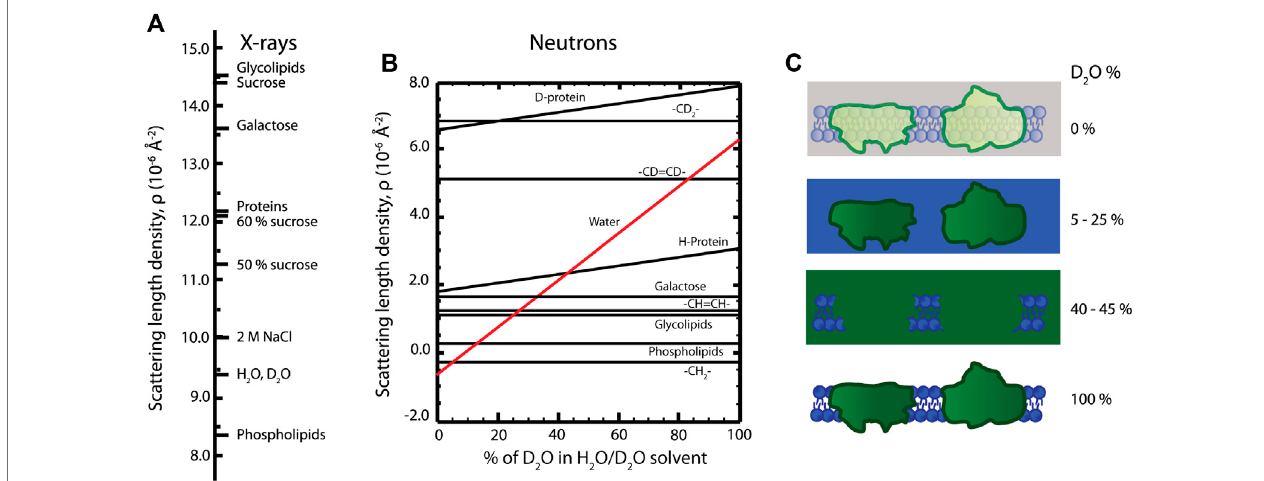
FIGURE 4 | (A) X-ray scattering length densities for various molecules. (B) Dependence of neutron scattering length densities of lipid and protein moieties on D 2 O amount in the sample. (C) Contrast variation technique, where a photosynthetic membrane is visualized in different D 2 O buffers. The signal from lipid (5 – 25% D 2 O) or protein components (40 – 45% D 2 O) is “ masked out. ” The total scattering signal is enhanced in 100% D 2 O, as indicated by more intense colors than in 0% D 2